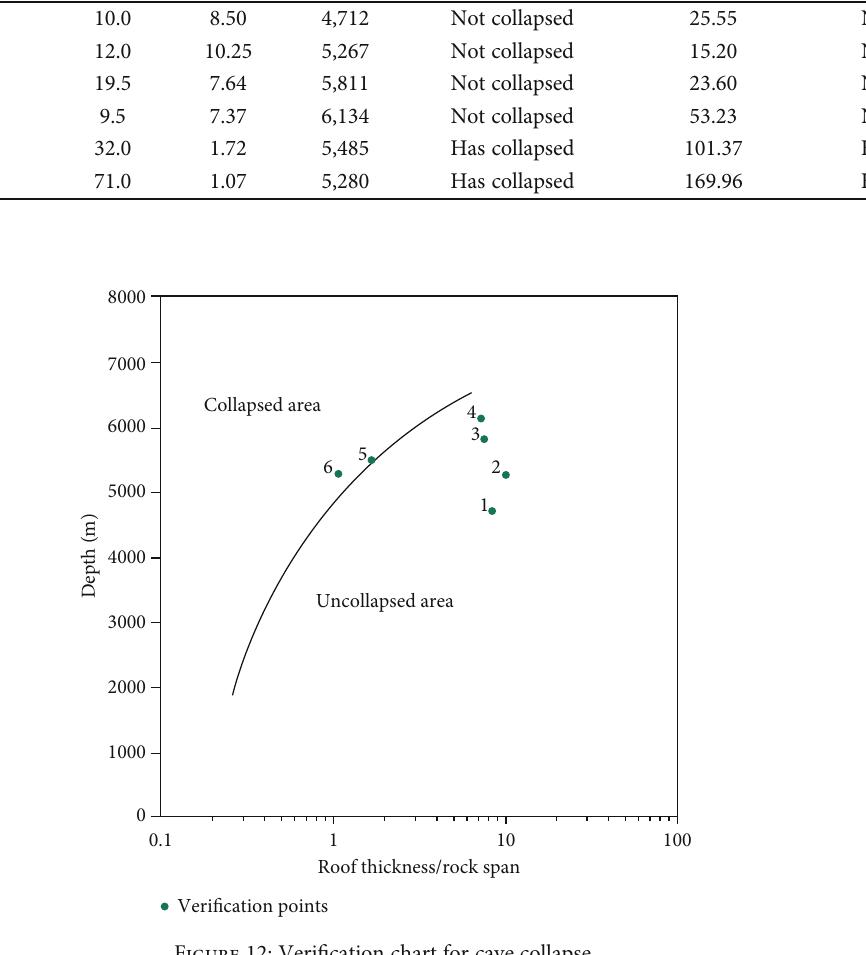
Figure 12: Veri fi cation chart for cave collapse.